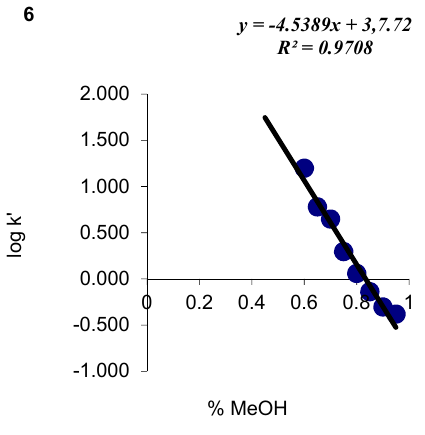
Figure 2. An experimental correlation between log k’ and the volume fraction of methanol mobile phase for compound 6.